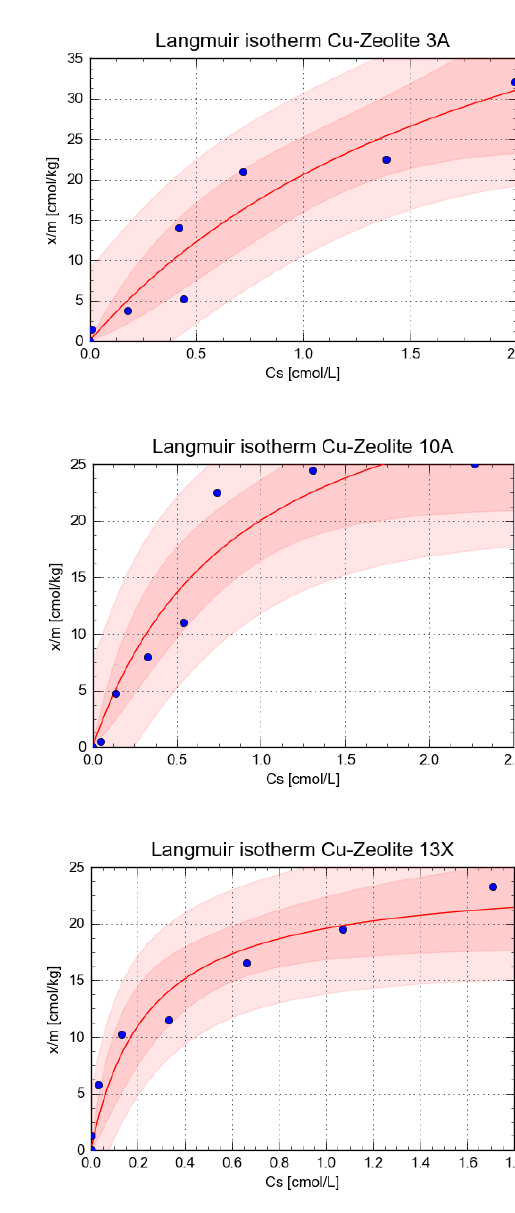
Figure 4. The Langmuir isotherms obtained in the study for sorption of Pb 2+ and Cu 2+ onto tested synthetic zeolites.